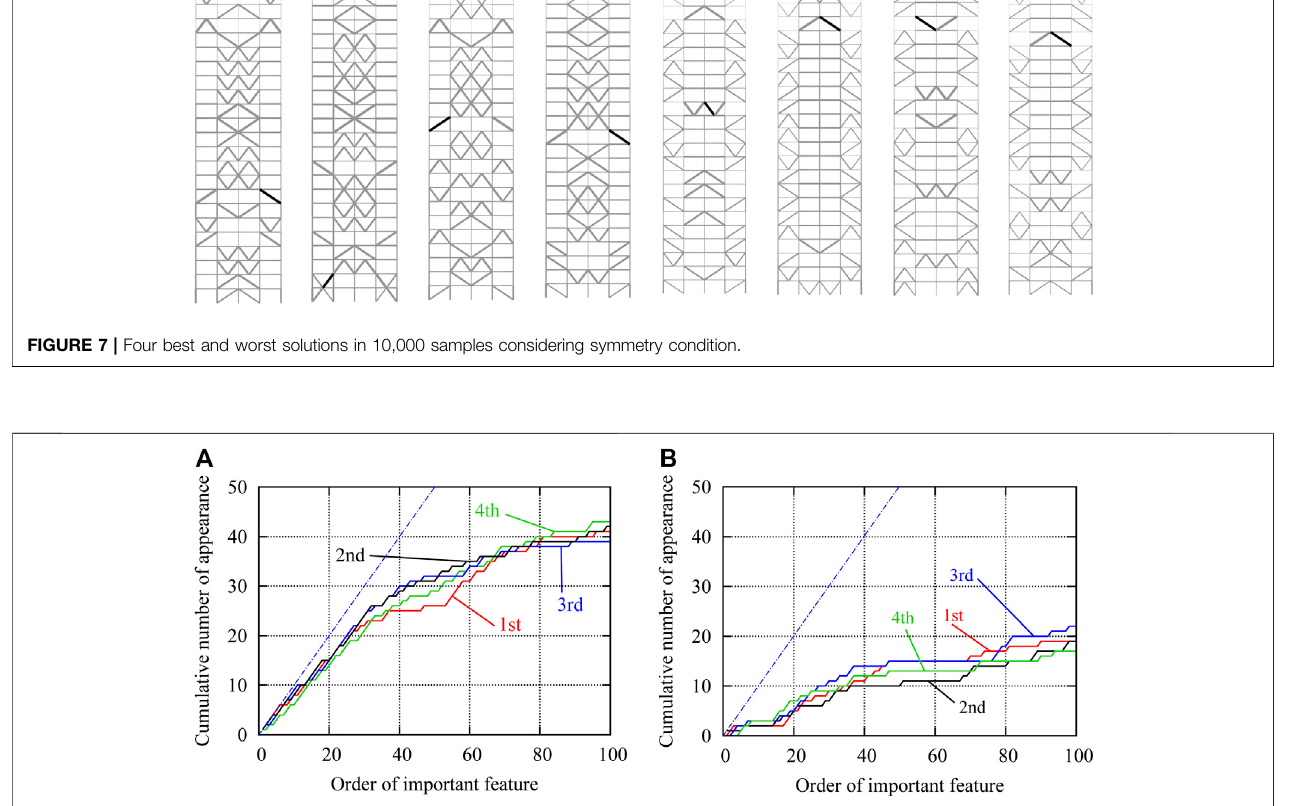
FIGURE 8 | Cumulative numbers of appearance of important features existing in the approximate optimal solutions; (A) approximate optimal solutions, (B) non- optimal solutions.